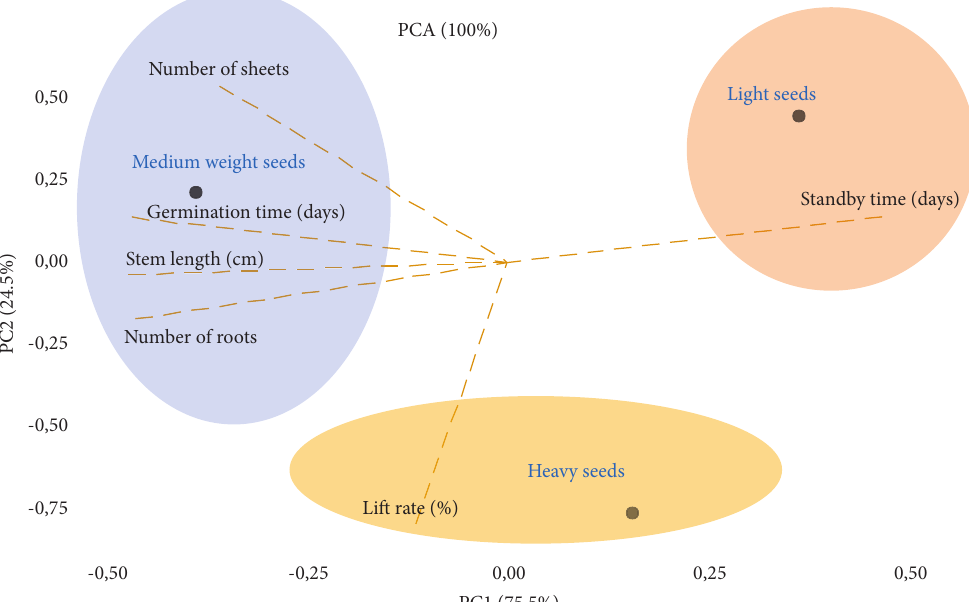
Figure 8: Summary of germination parameters for Balanites aegyptiaca at the Regional Centre for Agricultural Research (CERRA), Maradi,